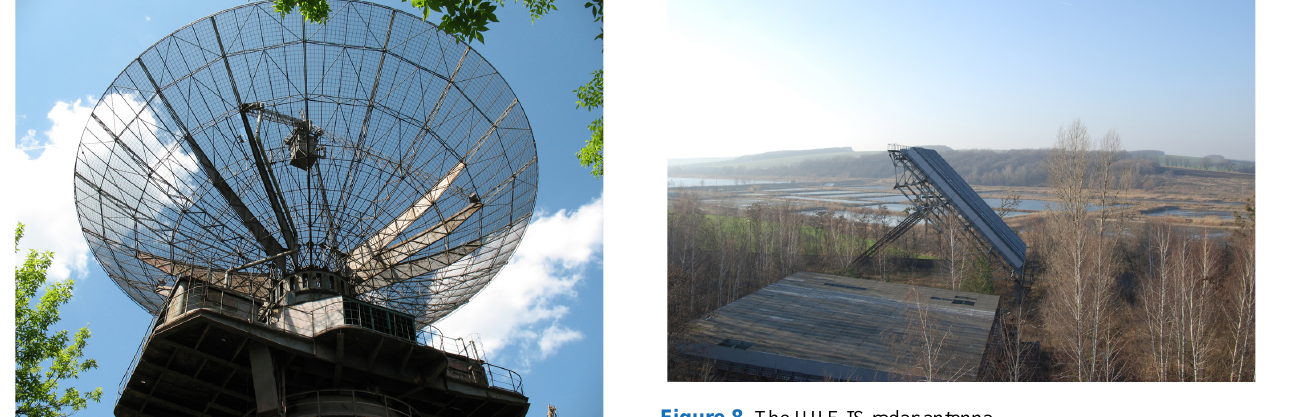
Figure 8. The UHF IS radar